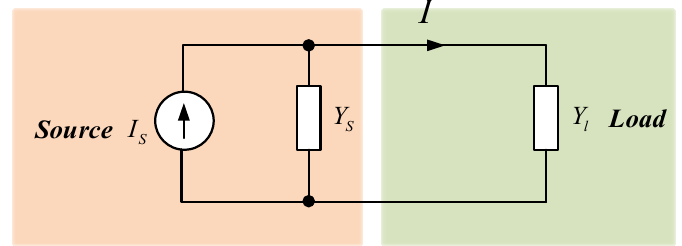
Figure 15. The presentation of the current-source system stability.